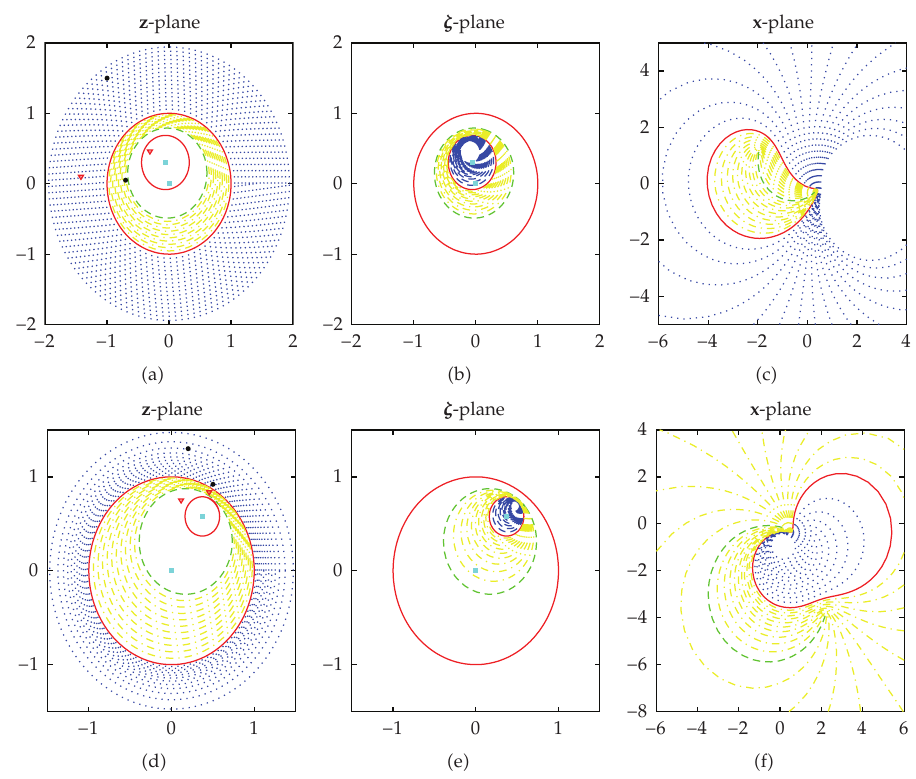
Figure 3: Planes of the variables: z (cid:2) first column (cid:3) , ζ (cid:2) second (cid:3) , and x (cid:2) third (cid:3) for vortices of kind 1 with respect to the first property. In the first row, a vortex of kind (cid:2) 1 , 1 (cid:3) (cid:2) a 1 (cid:7) 1, a 2 (cid:7) 0 . 1 (cid:6) i , z 1 (cid:7) − 0 . 70 (cid:6) 0 . 05 i , z 2 (cid:7) − 1 . 0 (cid:6) 1 . 5 i (cid:3) and in the second one a vortex of kind (cid:2) 1 , 2 (cid:3) (cid:2) a 1 (cid:7) 1, a 2 (cid:7) − 0 . 2 − 0 . 1 i , z 1 (cid:7) 0 . 2 (cid:6) 1 . 3 i , z 2 (cid:7) 0 . 50 (cid:6) 0 . 92 i (cid:3) are investigated. Two families of circles are considered in the z -plane: one inside A o (cid:2) yellow lines (cid:3) and the other one outside C (cid:2) blue lines (cid:3) . Image curves (cid:2) that are still circles in the ζ -plane (cid:3) are drawn with the corresponding colours. Circles C , C (cid:9) (cid:2) a (cid:3) , (cid:2) b (cid:3) , (cid:2) d (cid:3) , and (cid:2) e (cid:3) are drawn with red lines, as well as the vortex boundaries in (cid:2) c (cid:3) and (cid:2) f (cid:3) . Invariant circles C i (cid:2) t (cid:3) are drawn with green lines in (cid:2) a (cid:3) , (cid:2) b (cid:3) , (cid:2) c (cid:3) , and (cid:2) d (cid:3) . The same line is used to draw (cid:22) C (cid:2) t (cid:3) in (cid:2) c (cid:3) and (cid:2) f (cid:3) . The centers of C and C (cid:9) (cid:2) squared filled i symbols (cid:3) , the poles z 1 and z 2 (cid:2) solid black circular symbols (cid:3) and the conjugate points (cid:2) empty triangular symbols (cid:3) w 1 and w 2 are also